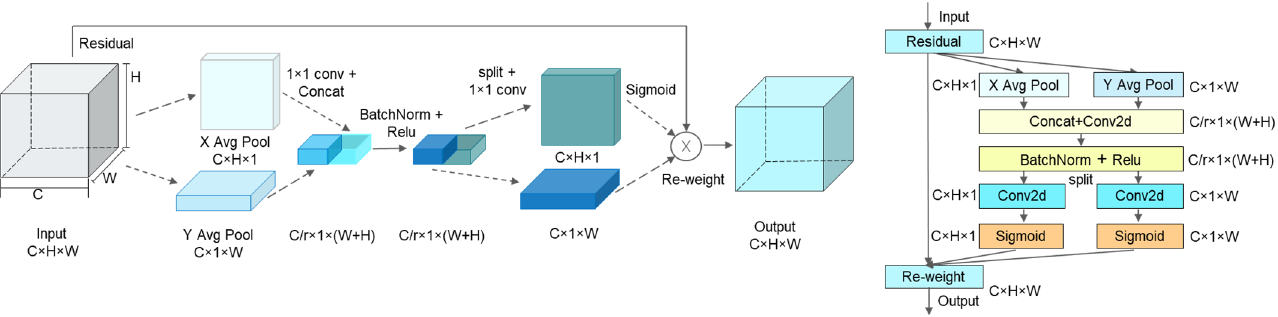
Figure 9. The Coordinate Attention workflow. C, H, and W are the number of channels, height, and width of the feature map, respectively. The r denotes the compression ratio of the channels.